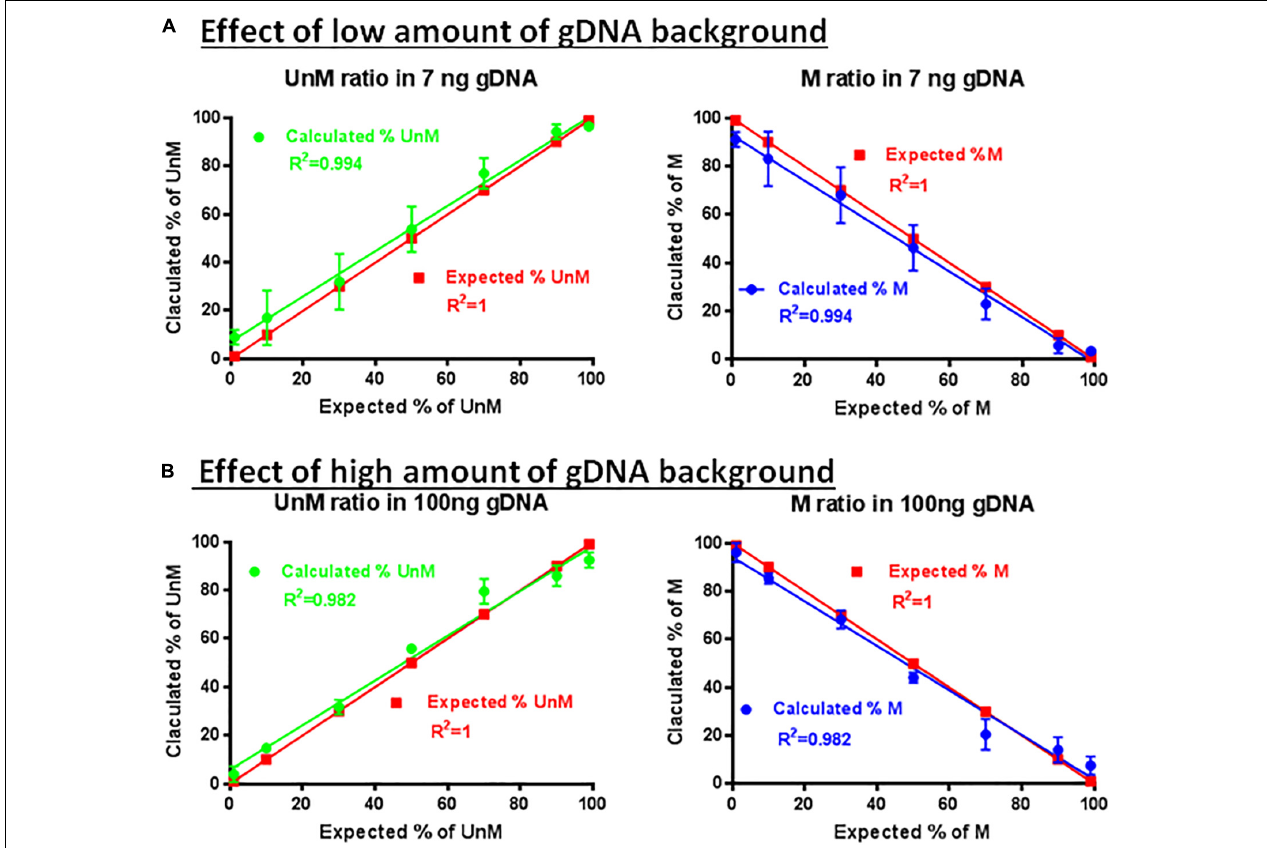
FIGURE 6 | Effect of non-specific gDNA on the specificity and sensitivity of ddMSP. Combinations of different ratios of unmethylated/methylated plasmids (1/99, 10/90, 30/70, 50/70, 70/30, 90/10, and 99/1) in the presence of low (A) or high amounts (B) of non-specific gDNA as background. Mixture analyzed by ddPCR using primers specific to TSDR and probes for methylated and unmethylated CpGs. Linear regression analysis for methylated and unmethylated targets showed no effect of non-specific background. The data shown are the average with standard deviation (SD) of three